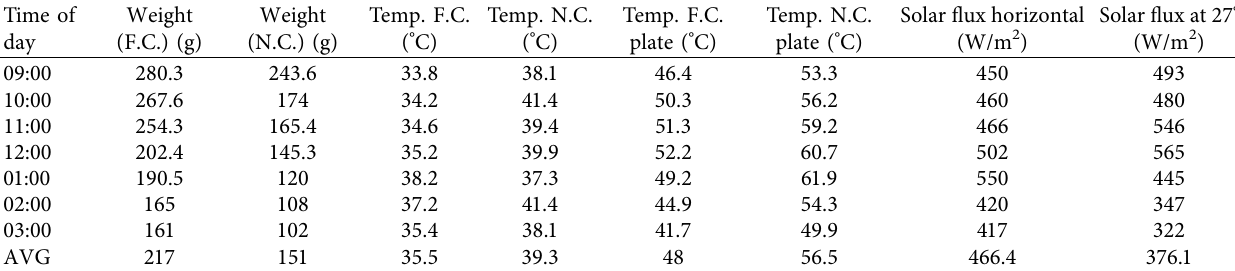
Table 6: Observation of fenugreek in the solar dryer in direct sunlight.